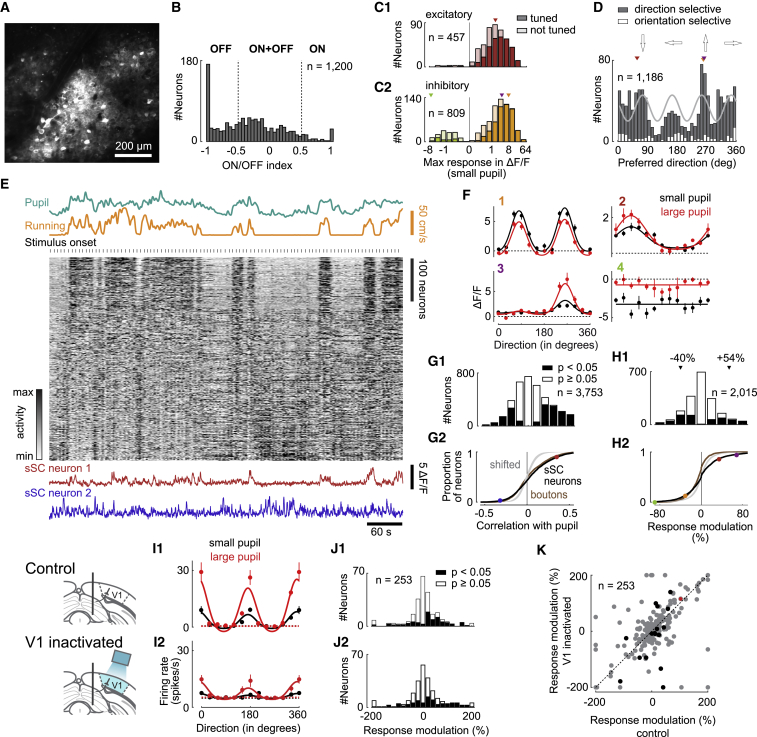
Visual Responses and Effect of Arousal on Neurons in SC(A) Average frame of two-photon imaging data shown in (H).(B) Distribution of ON/OFF indices across SC neurons.(C) Distribution of maximum amplitudes in response to gratings for excitatory (C1) and inhibitory neurons (C2). Dark bars represent neurons tuned to direction; light bars represent untuned neurons. Triangles show responses of examples in F.(D) Distribution of preferred directions of neurons that are direction selective (gray bars) or only orientation selective (white bars). Fourth harmonic (light gray line) was fit using Fourier decomposition. Triangles show preferred directions of examples 1–3 in (F).(E) Data from one experimental session recorded during presentation of gratings. Calcium traces in gray scale were each Z scored and then sorted by correlation with pupil size in the first half of data; only the second half is presented to show the robustness of correlations.(F) Direction tuning (mean ± SEM) of four neurons during trials where the pupil was small (black) or large (red).(G) Correlations of SC neurons with pupil size during presentation of gratings. Shaded area (G2): 2.5-97.5 percentile interval of null distribution. Brown line shows correlations of retinal boutons (same as in Figure 2F). Dots show correlations of example neurons in E.(H) Distribution of response modulation (measured and null). Dots: values of examples in F.(I) Direction tuning (mean ± SEM) of SC neurons during trials where the pupil was small (black) or large (red). Tuning curves were measured during control conditions (I1) and V1 inactivation (I2). Dotted lines show baseline firing rates.(J) Distribution of response modulations during control conditions (J1) and V1 inactivation (J2).(K) Response modulation during control conditions versus V1 inactivation for neurons with nonsignificant changes in response modulation (p < 0.05, permutation test, gray dots) and neurons with significant changes (black dots). Red dot marks values of neuron in (I).